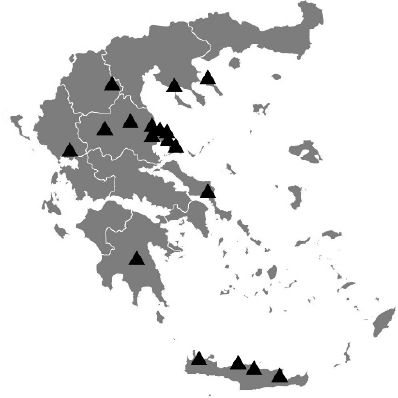
Figure 2. Geographic locations of bee bread samples.